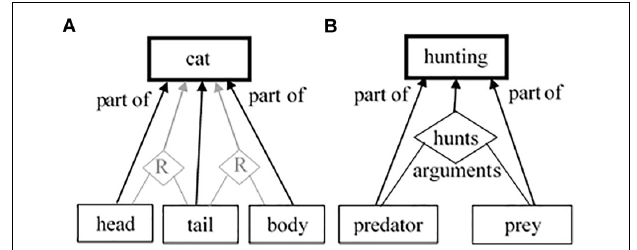
FIGURE 1 | Schematic description of the meaning of a feature-based category cat (A) and of a relation-based schema for hunting (B) . The diamond shape hunts points to a relational concept. We assume that (A) and (B) are not two distinct types of categories but are two extremes of a continuum. Even in the cat representation (A) , we can add some spatial relations between the cat’s parts (All links are